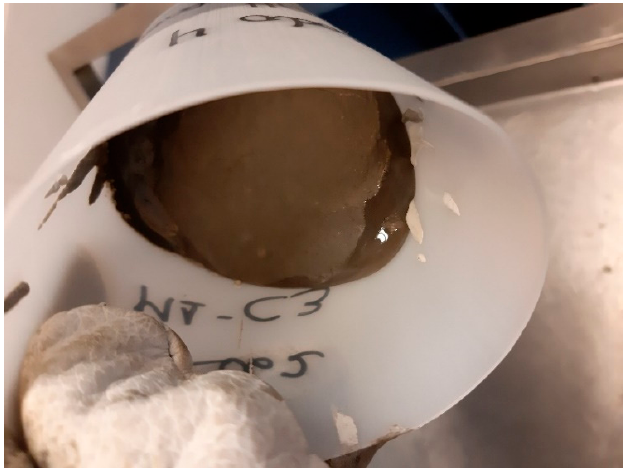
Figure 11. Consistency of Method IV, 1 day set at room temperature.